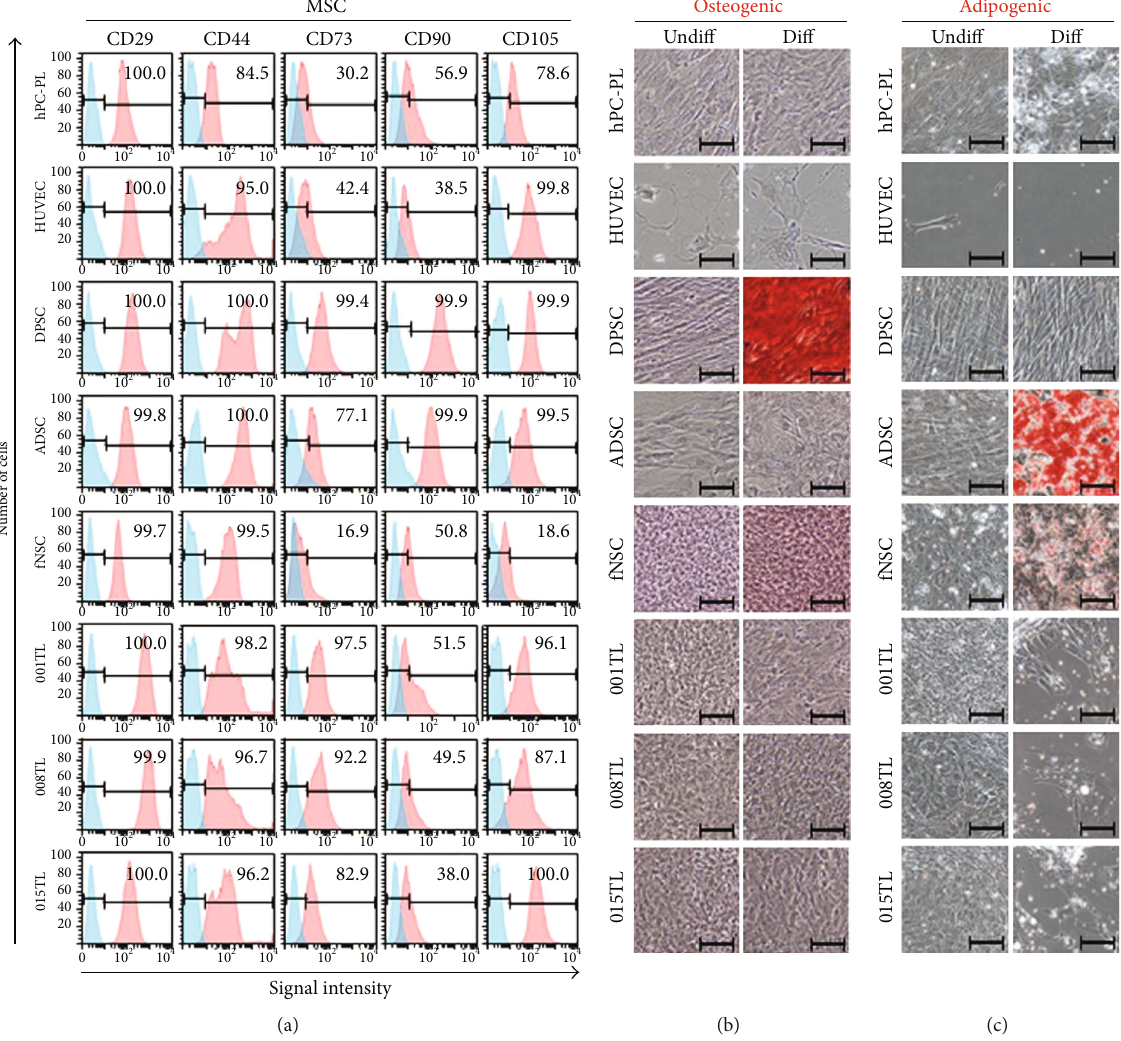
Figure 3: Expression of MSC markers and in vitro di ff erential potential into mesenchymal lineage cells of ahMNCs. (a) Protein levels of MSC markers were analyzed by fl ow cytometry. Number in each panel indicated percent of marker-positive cells. (b, c) Cells were maintained in osteogenic (b) or adipogenic (c) di ff erentiation medium for 17 days (Di ff ). Undi ff erentiated cells (Undi ff ) were maintained in α -MEM supplemented with 5% FBS for 17 days. (b, c) Calcium deposit (b) and lipid vacuoles (c) were then stained with Alizarin red S and Oil red O solution, respectively. Scale bars, 100 μ